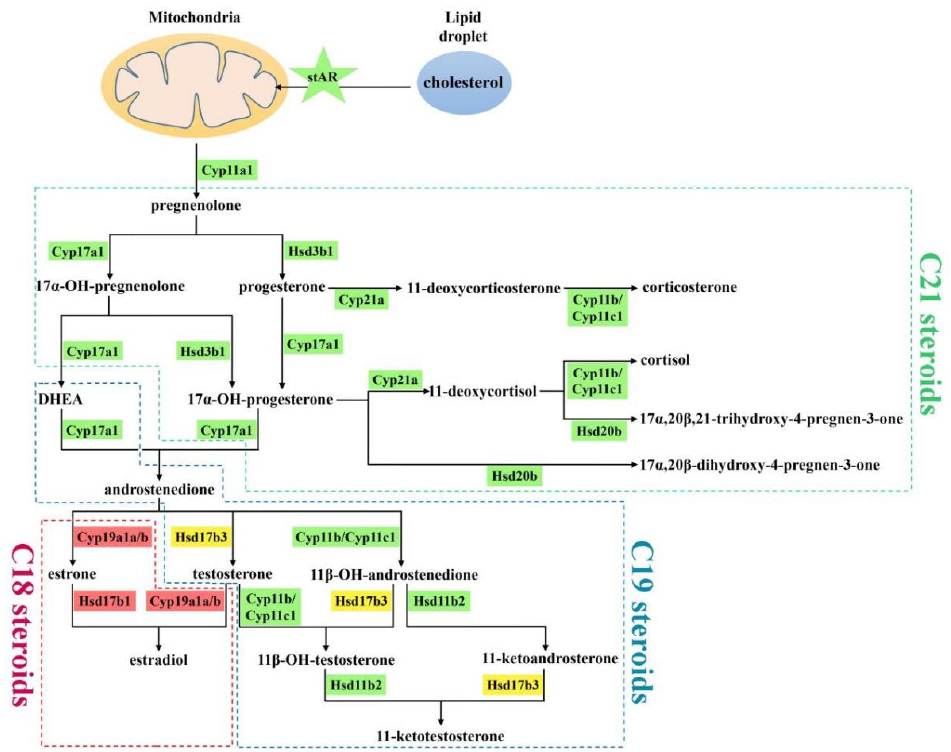
Figure 7. Putative steroid hormone biosynthesis pathway in P. olivaceus and C. semilaevis . Genes with green background represent higher expression in testis, genes with red background represent higher expression in ovaries, and controversial expression genes were represented with yellow background.